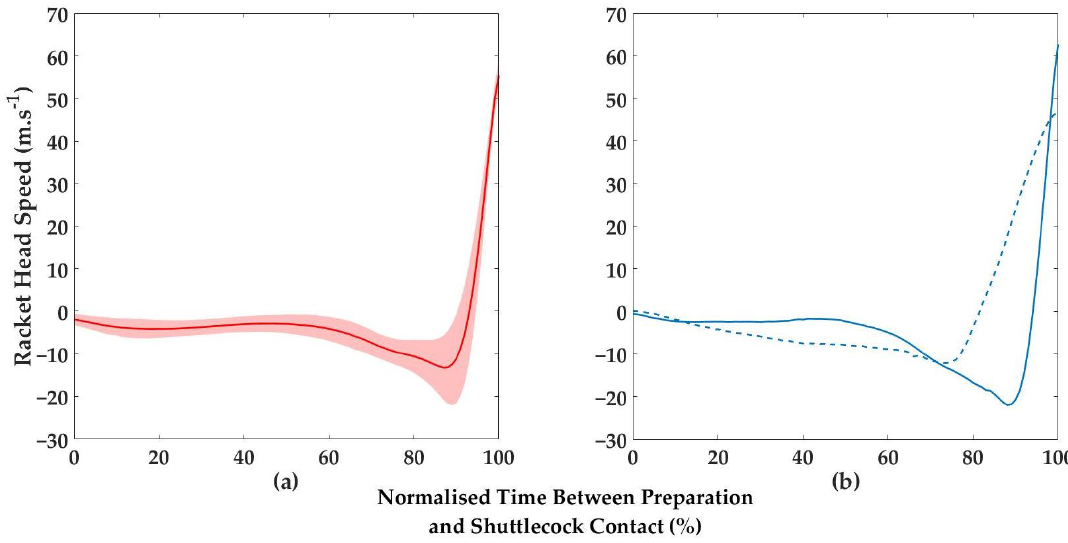
Figure 5. ( a ) Mean (solid line) ± SD (shaded area) for the normalised racket head speed between preparation and shuttlecock contact key instants for all participants; ( b ) Normalised racket head speed (normal to the stringbed plane) between preparation and shuttlecock contact key instants for participants with the fastest (solid line) and slowest (dashed line) smash. The acceleration phase begins at the point at which the racket head speed becomes positive, following the initial negative peak, and the duration between this turning point and shuttlecock contact was significantly negatively correlated with shuttlecock speed.